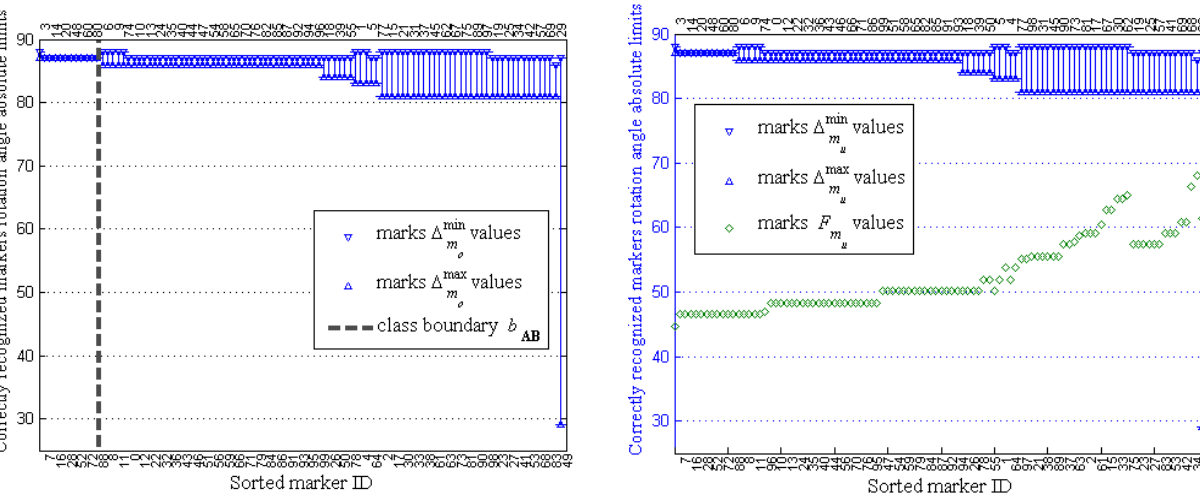
Fig. 10. Marker recognition results sorted using three-fold criteria: (4a), (5) , and (8). Note: marker IDs are shown pair wise at the bottom and the top of axis; relative failure index F m values are indicated at the right side of